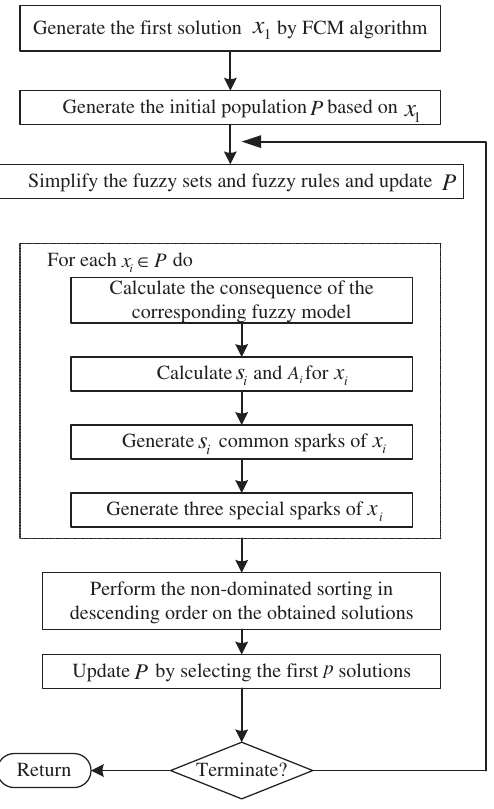
Figure 1: Flowchart of the Fuzzy Model Construction Based on NSFOA.